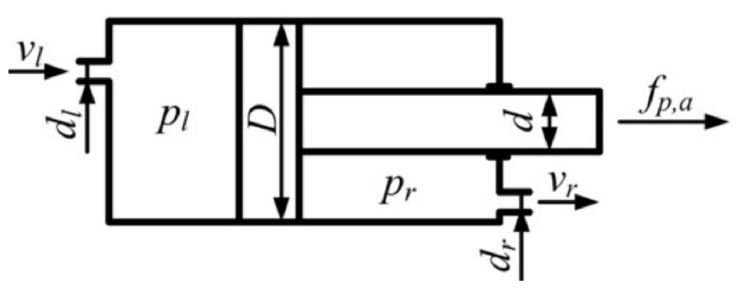
Figure 5. The schematic diagram of a hydraulic actuator with a single-piston